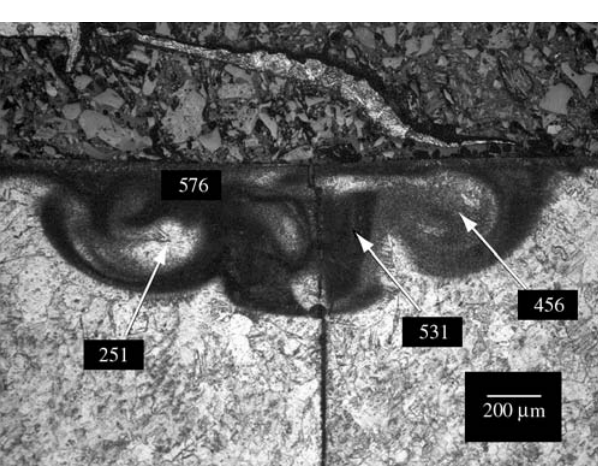
Figure 6. Normal conditions weld test with an expanded beam. The numbers refer to the average microhardness